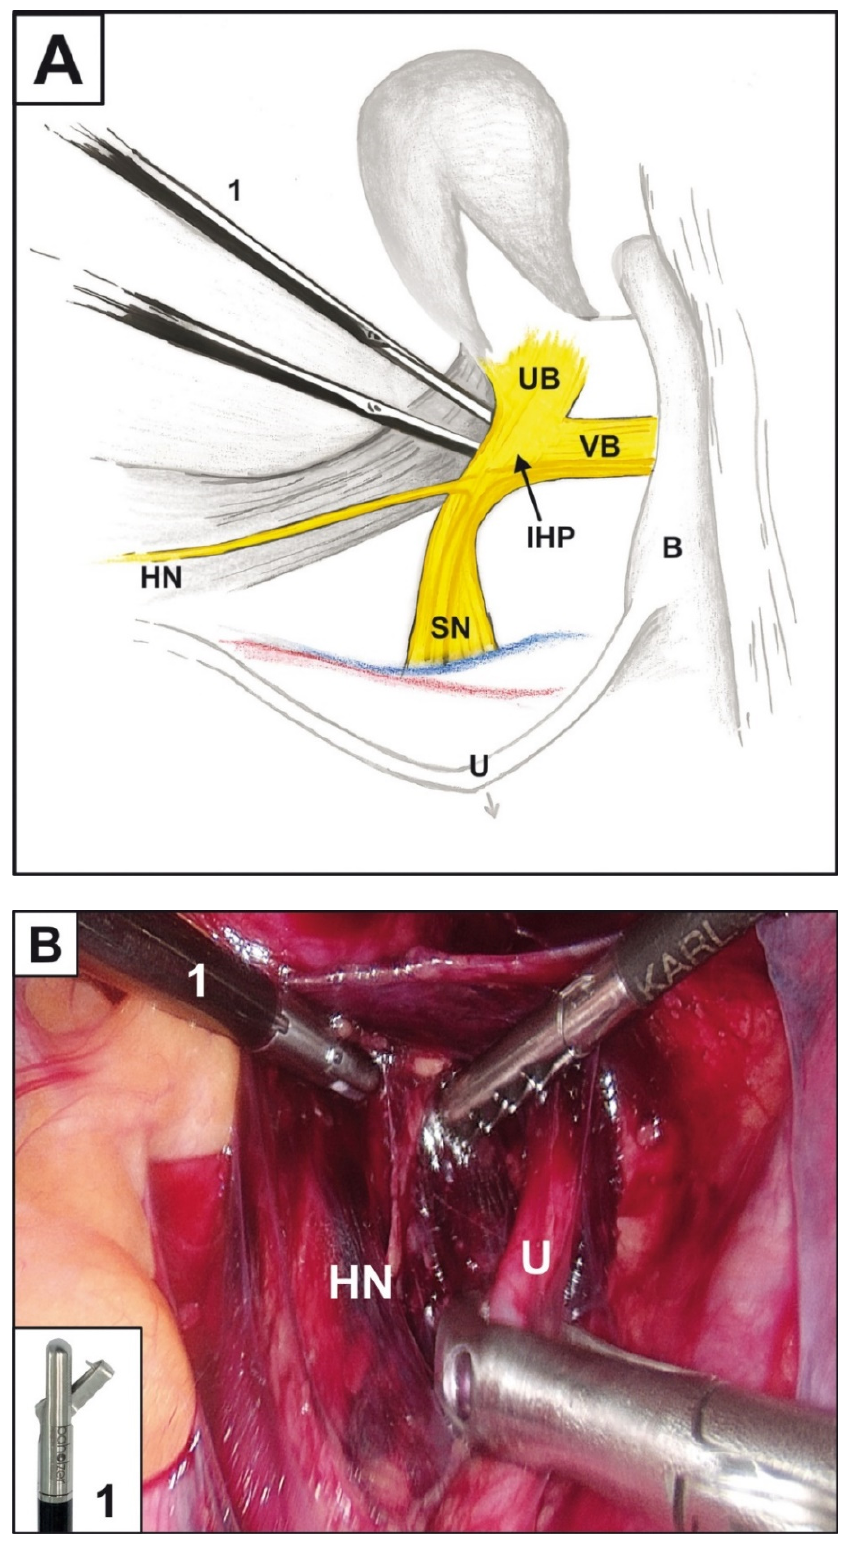
Figure 1. Laparoscopic biopsy of uterine branches: ( A ). Scheme; ( B ). Laparoscopic view. Legends: